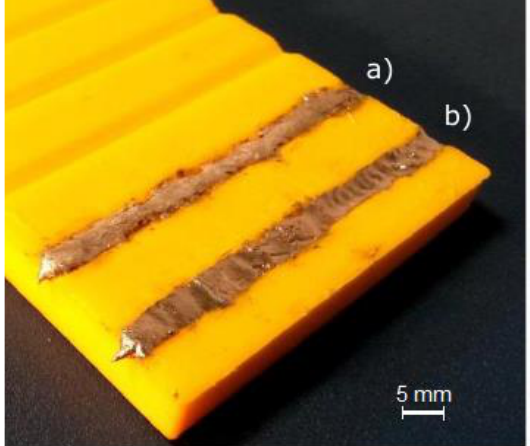
Figure 4. Conductive paths obtained using aluminum nozzle by filling grooves in ABS substrate with ( a ) Sn99Ag0.3Cu0.7 and ( b ) Sn60Pb40 solder alloy. ( a ) Sn99Ag0.3Cu0.7 and ( b ) Sn60Pb40 solder alloy.